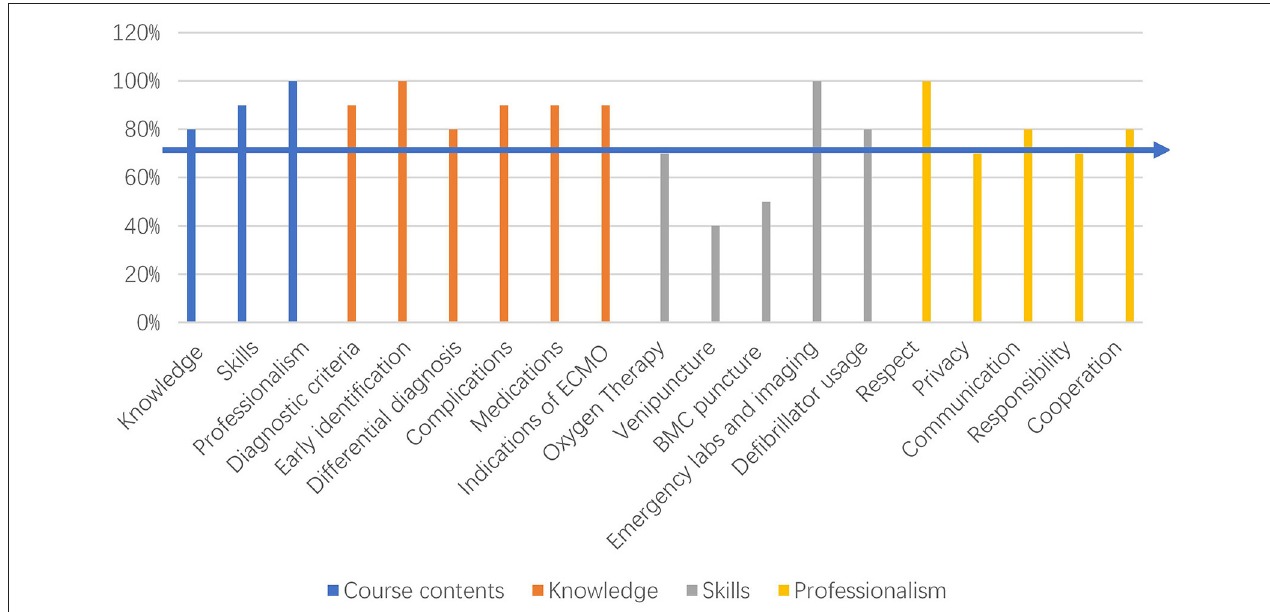
FIGURE 2 | Teaching schedule of the novel simulation course with the segmented model (acute fulminant myocarditis in children).